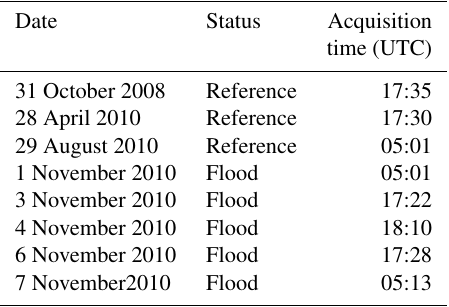
Table 1. List of COSMO-SkyMed SAR data (Stripmap 3m) used for deriving flood maps of the